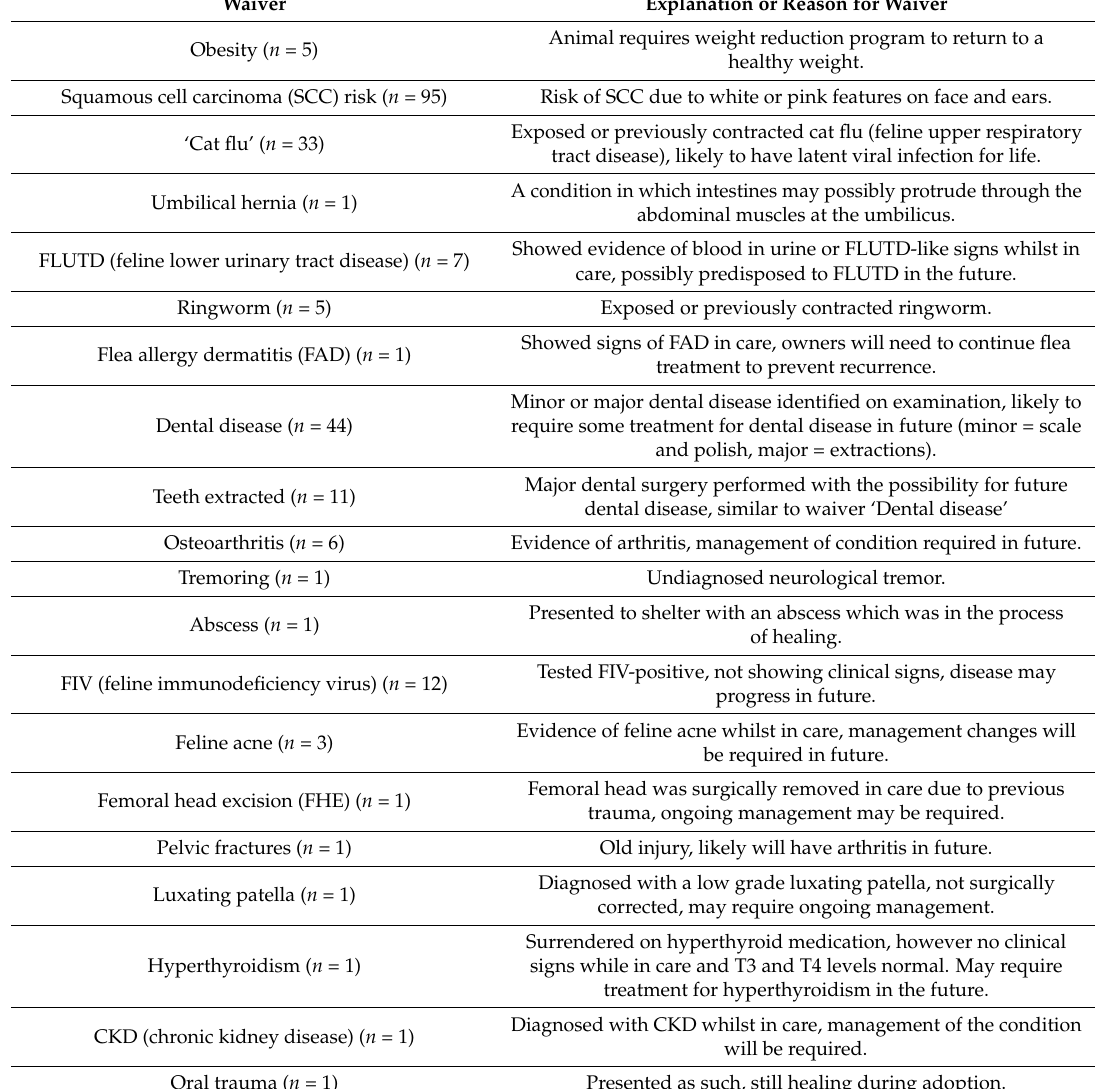
Table 1. Cat adoption waivers used at the RSPCA Weston shelter in the ACT, Australia with accompanying explanations for potential